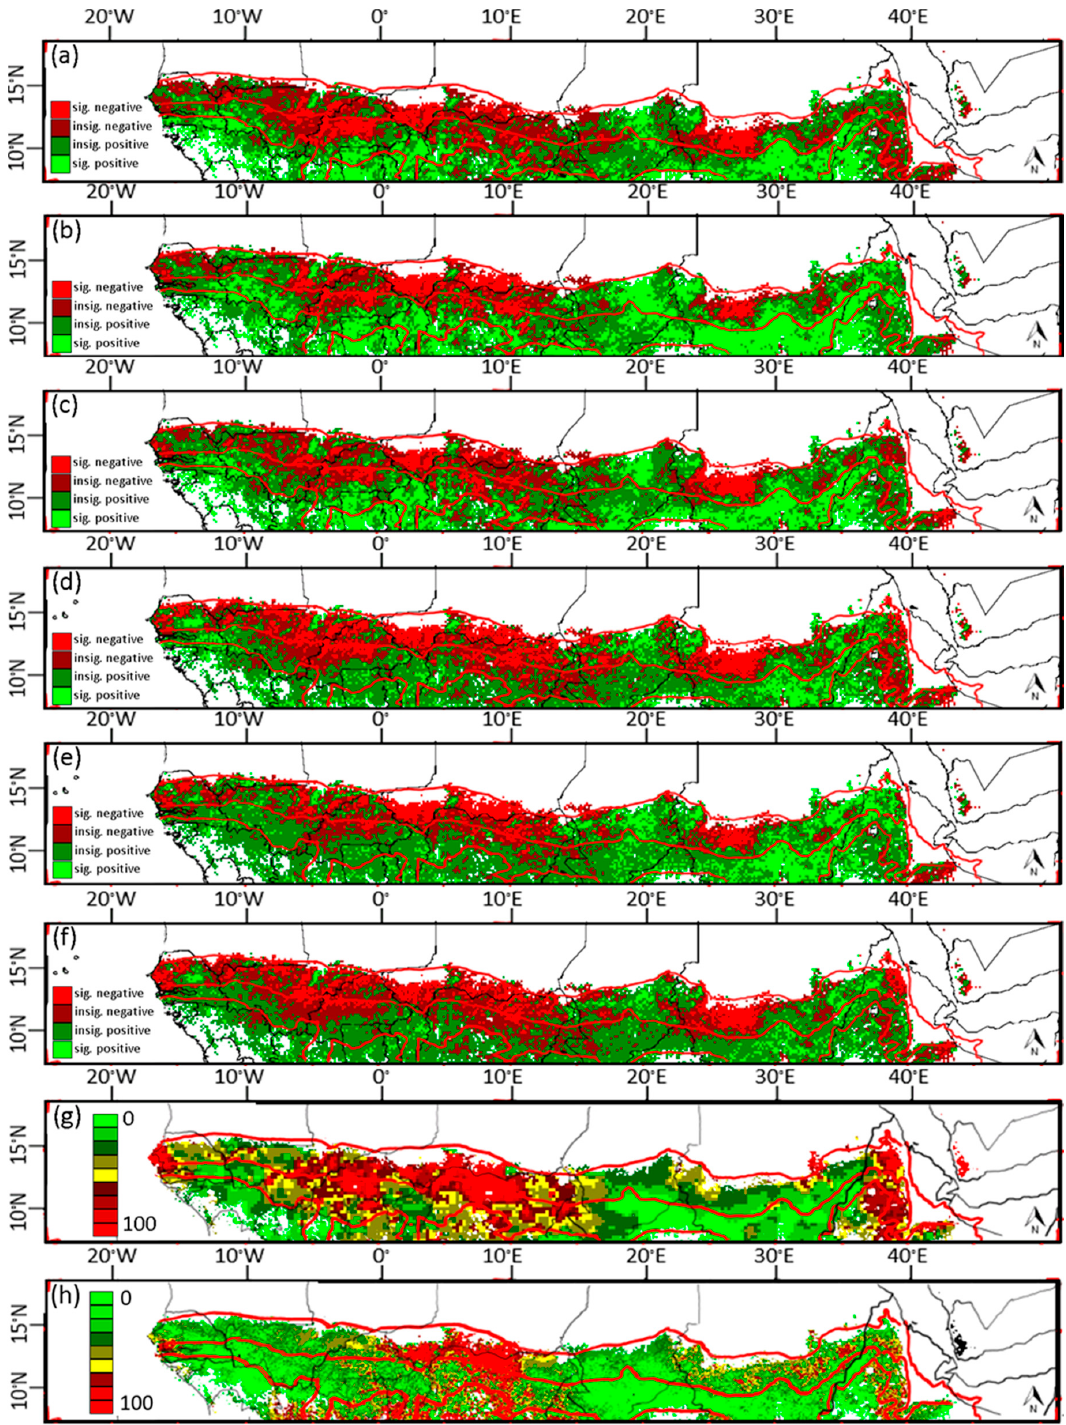
Figure 4. Residual trends and two maps of human land use. ( a – f ) Trends (slopes) of NDVI gs residuals (observed–potential) over time as obtained from the six RESTREND models (A) through (F); see Table 2); ( g ) % Human Appropriation of Net Primary Production (%HANPP); and ( h ) proportion of cropland datasets used to explore the relationship between RESTREND value and land use [5,59]. The red lines from north to south are the 300 mm, 700 mm and 1100 mm rainfall isohyets.